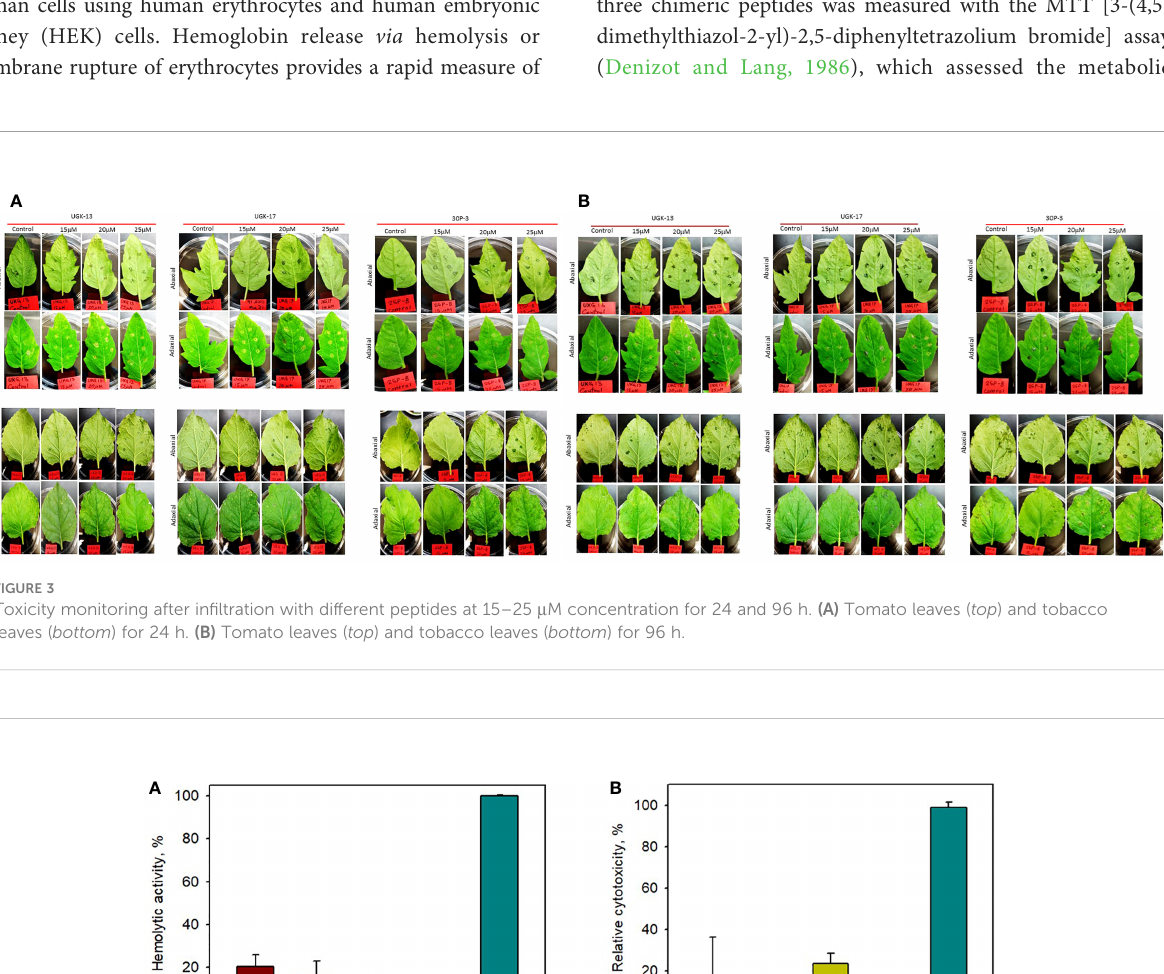
Water was used as the non-toxic